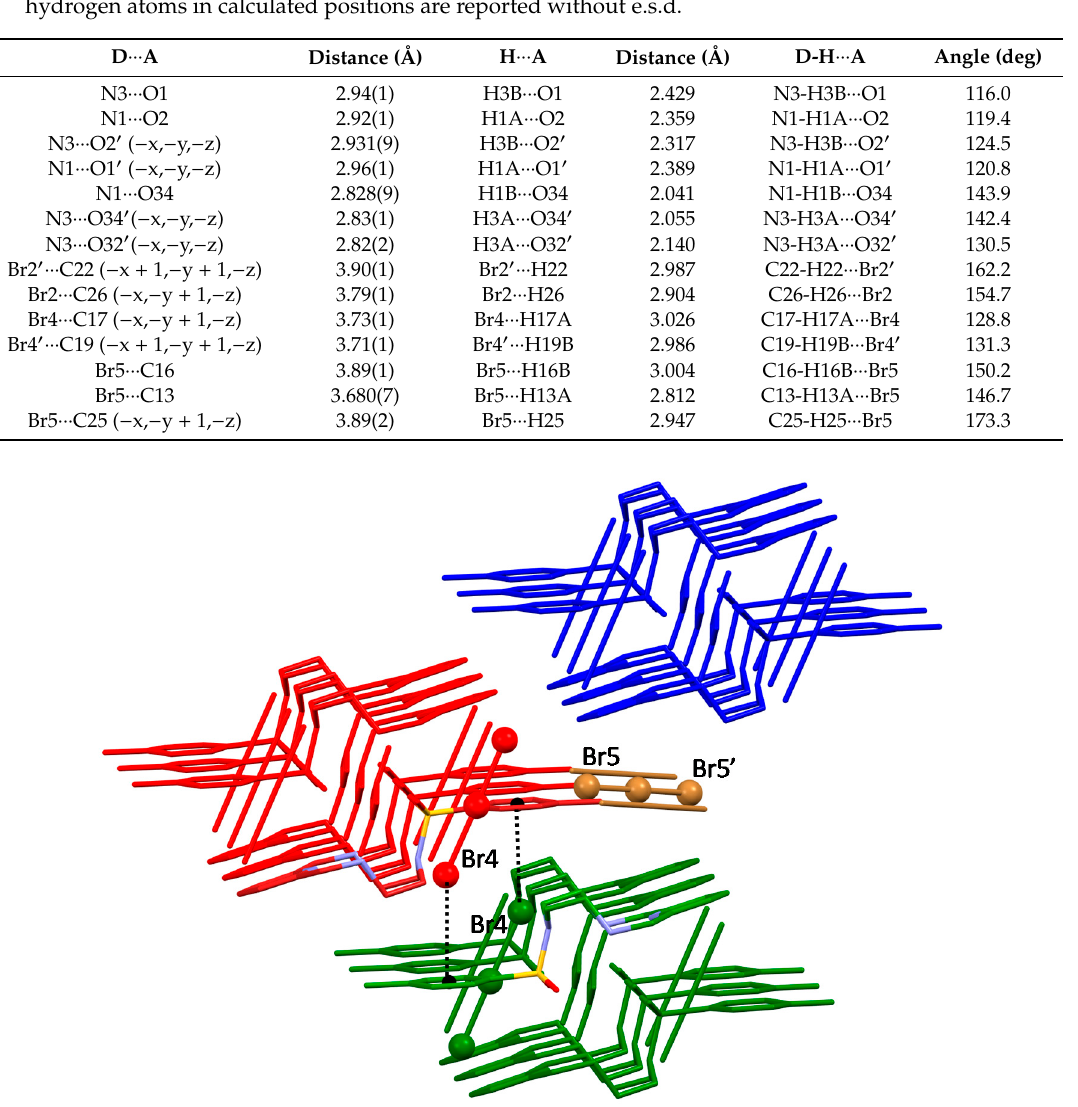
Figure 4. View of the crystal structure of (H 2 L-Ts)(Br 3 ) 1.5 (NO 3 ) 0.5 highlighting the end-on anion- π interactions formed by one of the crystallographically non-equivalent Br 3 − anions with benzene rings.